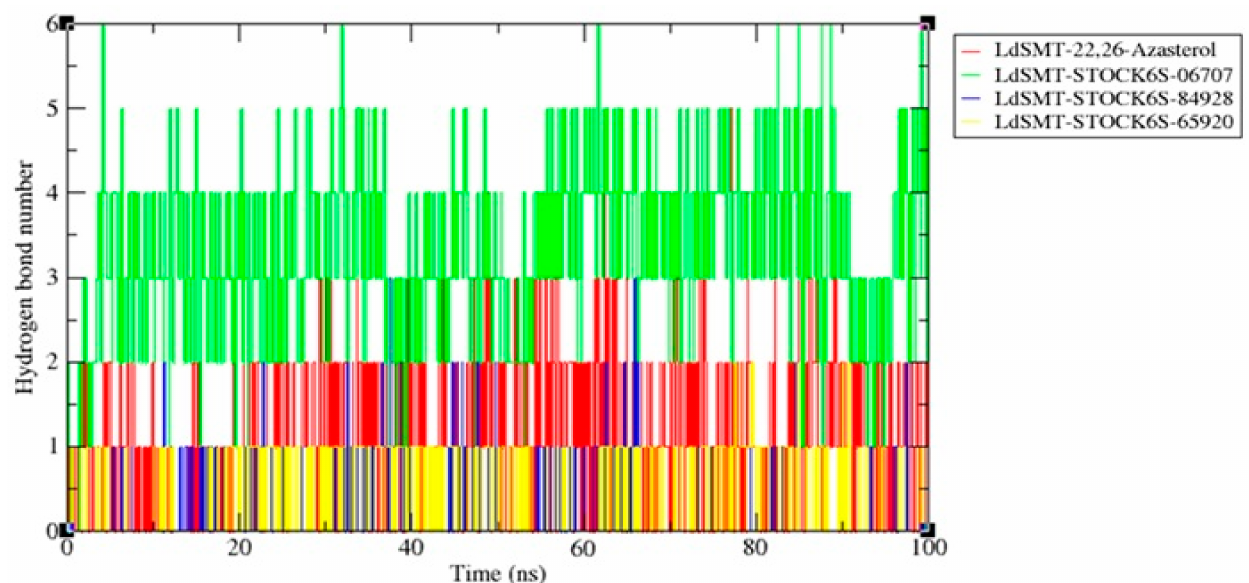
Figure 6. Number of hydrogen bond interactions of the protein–ligand complexes throughout the MD simulation period. Number of hydrogen bonds in Ld SMT–22,26-azasterol, Ld SMT–STOCK6S-06707, Ld SMT–STOCK6S-84928, and Ld SMT–STOCK6S-65920